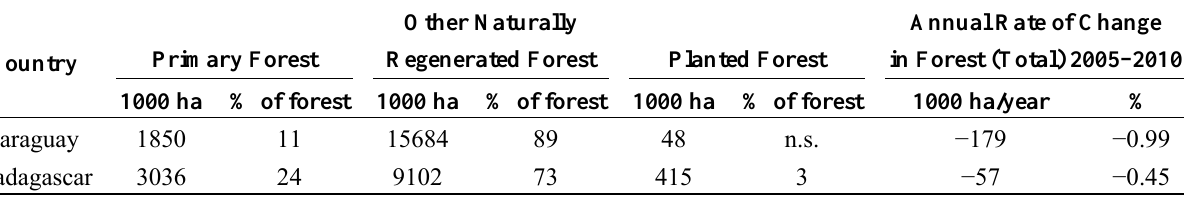
Table 1. Forest Cover in Madagascar and Paraguay.